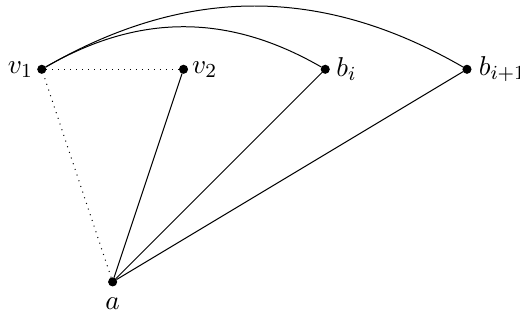
Figure 4: The elimination process for Theorem 3.3, Case 1. Repeatedly (for different i ) perform the jumps v b 1 i +1